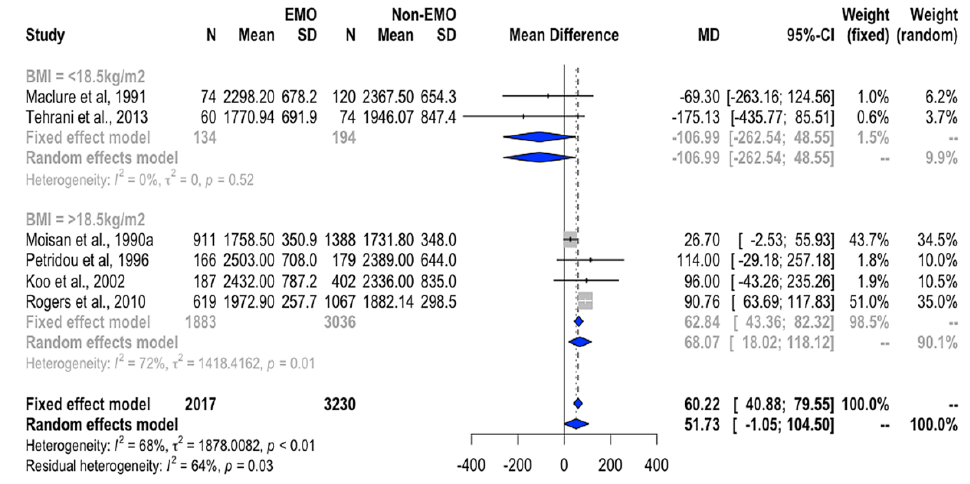
Figure 2. Forest plot of WMD of EI between EMO and NEMO groups stratified by BMI < 18.5 kg / m 2 and BMI ≥ 18.5 kg / m 2 . Definition of abbreviations: EMO, earlier menarche onset; NEMO, non-early menarche onset; MD, mean difference; WMD, weighted mean difference.